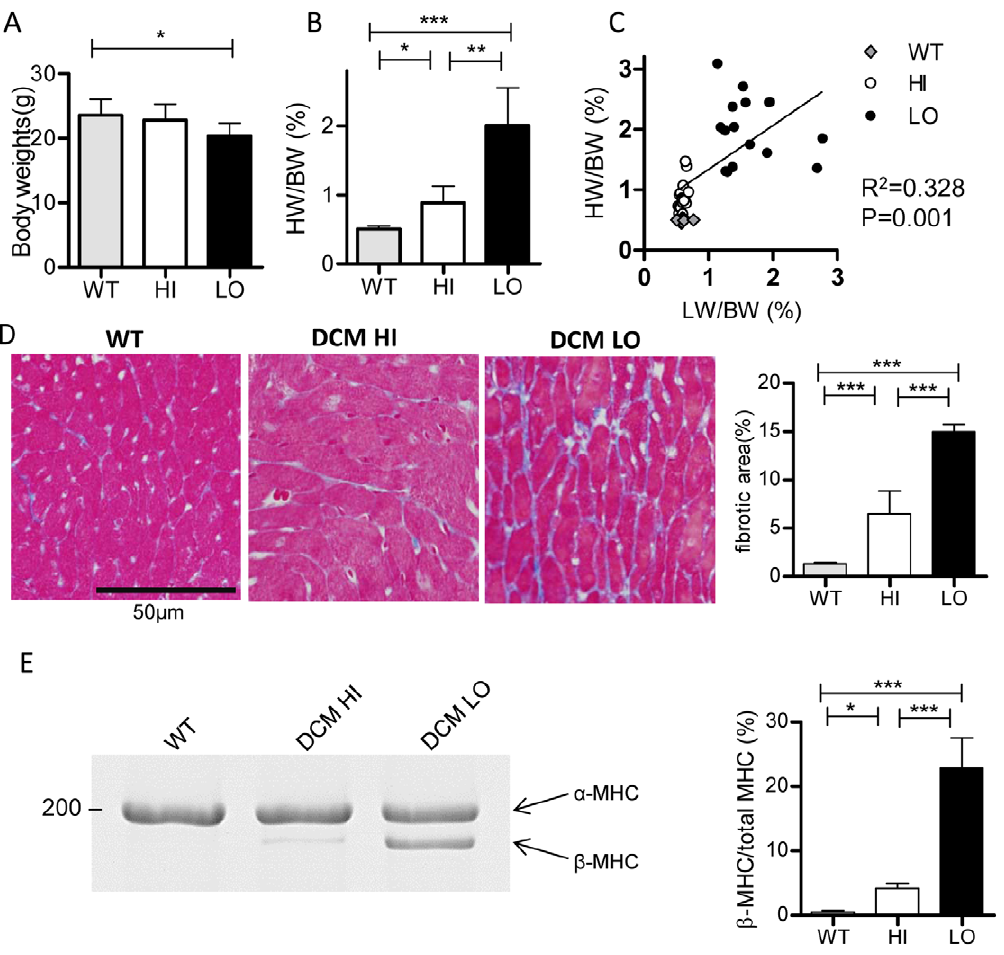
Figure 4. Heart weights, myocardial fibrosis, and protein expression level of b -MHC in myocardium. A. Body weight. B. HW/BW ratio. Data are mean 6 SD. *P , 0.05, **P , 0.01, ***P , 0.001. C. HW/BW to LW/BW ratio relationship. Linear regression revealed a positive correlation between HW/BW and LW/BW in all DCM mice (P=0.001). D. Histological analysis of the fibrosis in left ventricular myocardium. Connective tissues were stained blue with azan. Left three panels: representative data from WT and DCM HI and LO group mice. Right: Averaged fibrosis area. Data represent the mean 6 SD for three mice. E. Protein expression level of b -MHC in left ventricular myocardium. Left: Representative Coomassie brilliant blue staining pattern of a - and b -MHC in individual experiments. Right: Averaged expression levels. The expression level for b -MHC was normalized to the total MHC ( a -MHC + b -MHC). Data are means 6 SD (WT: n =4, DCM: n =5). *P , 0.05, **P , 0.01, ***P , 0.001 vs. WT.